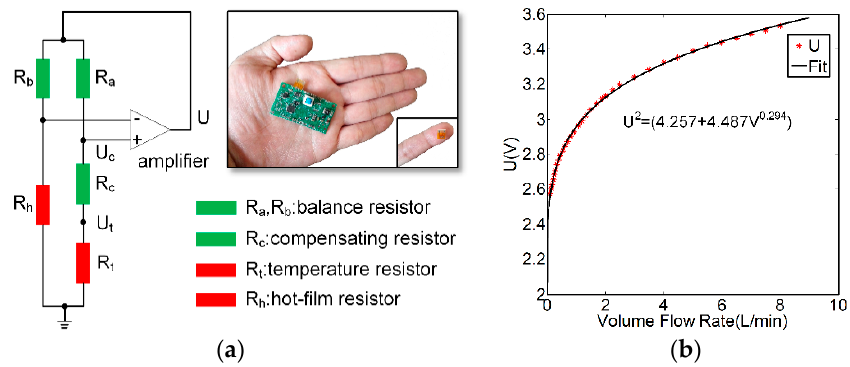
Figure 4. ( a ) Schematic diagram and prototype of the airflow-temperature sensor. ( b ) Relationship between the output voltage U shown in ( a ) and airflow rate.